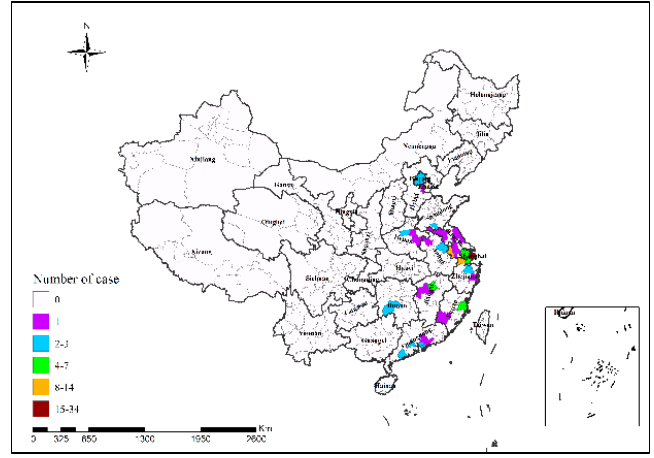
Figure 2. Spatial pattern of H7N9 outbreaks in China in 2013.